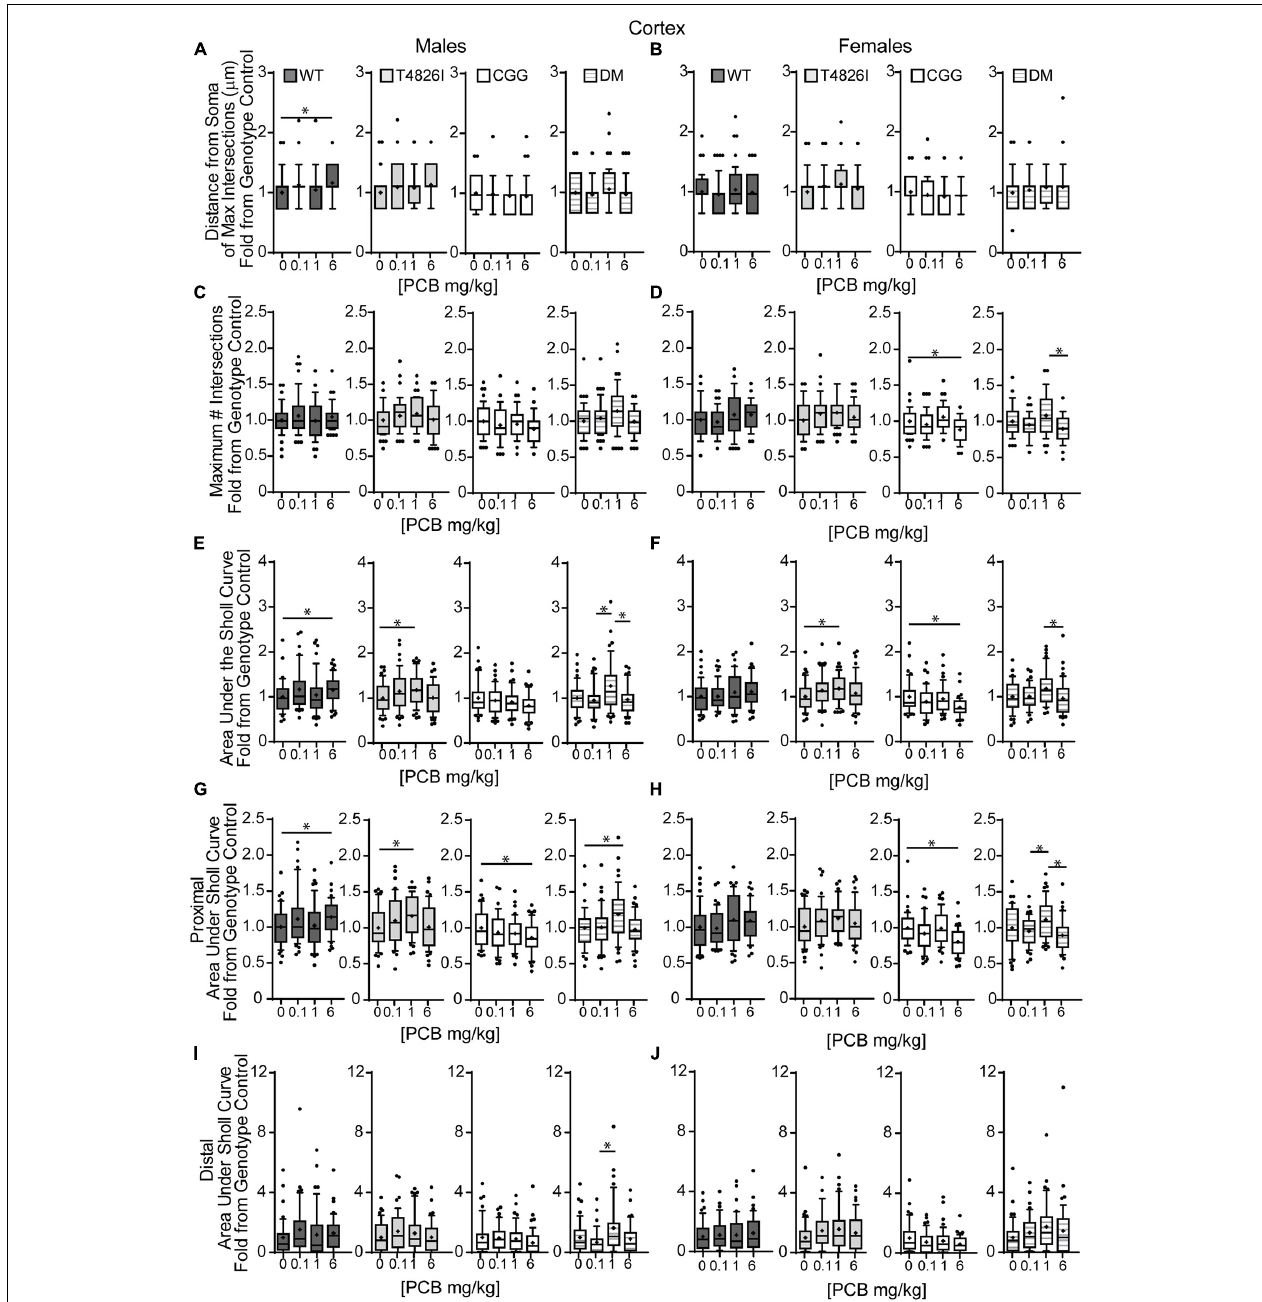
FIGURE 5 | Effects of PCBs on the dendritic morphology of pyramidal neurons in the somatosensory cortex of juvenile mice vary between genotypes and are dose and sex dependent. Morphometric analyses of the basilar dendritic arbors of Golgi-stained pyramidal CA1 hippocampal neurons from P27-31 male and female WT, T4826I, CGG, or DM mice exposed to the MARBLES PCB mixture in the maternal diet throughout gestation and lactation. (A,B) The distance from the soma to the maximum number of dendritic intersections (Peak X). (C,D) The maximum number of dendritic intersections (Peak Y). (E,F) The total area under the curve of the Sholl plot (0–280 µ m from the soma). (G,H) Proximal area under the curve of the Sholl plot (10–70 µ m from the soma). (I,J) Distal area under the curve of the Sholl plot (80–140 µ m from the soma). Data ( N = 44–48 neurons from at least six independent mice per sex per genotype per dose) are presented as box plots, where the box indicates the lower (25th) to upper (75th) quartiles, the “+” indicates the mean, whiskers indicate the 10–90th percentile, and dots represent values outside the upper or lower fences. Bar and asterisk indicate a significant difference between groups as determined by Kruskal–Wallis test followed by Dunn’s multiple comparisons test, or (E-T4826I, G-CGG) one-way ANOVA followed by Dunnett’s multiple comparisons test or (H-DM) Tukey’s multiple comparisons test with p ≤ 0.05 considered statistically significant. Average values of vehicle controls for WT, T4826I, CGG and DM, respectively, are (A) 27.2, 27.1, 30.8, 30.2 µ m; (B) 31.0, 27.7, 31.9, 27.1 µ m; (C) 10.1, 9.9, 11.0, 9.6 intersections; (D) 10.0, 9.9, 10.9, 10.5 intersections; (E) 504.0, 502.9, 603.5, 534.2 µ m 2 ; (F) 522.7, 516.4, 642.1, 522.7 µ m 2 ; (G) 403.8, 396.4, 466.4, 405.5 µ m 2 ; (H) 407.9, 418.8, 477.8, 428.9 µ m 2 ; (I) 52.7, 58.5, 81.4, 74.4 µ m 2 ; and (J) 64.9, 52.8, 101.4, 47.2 µ m 2